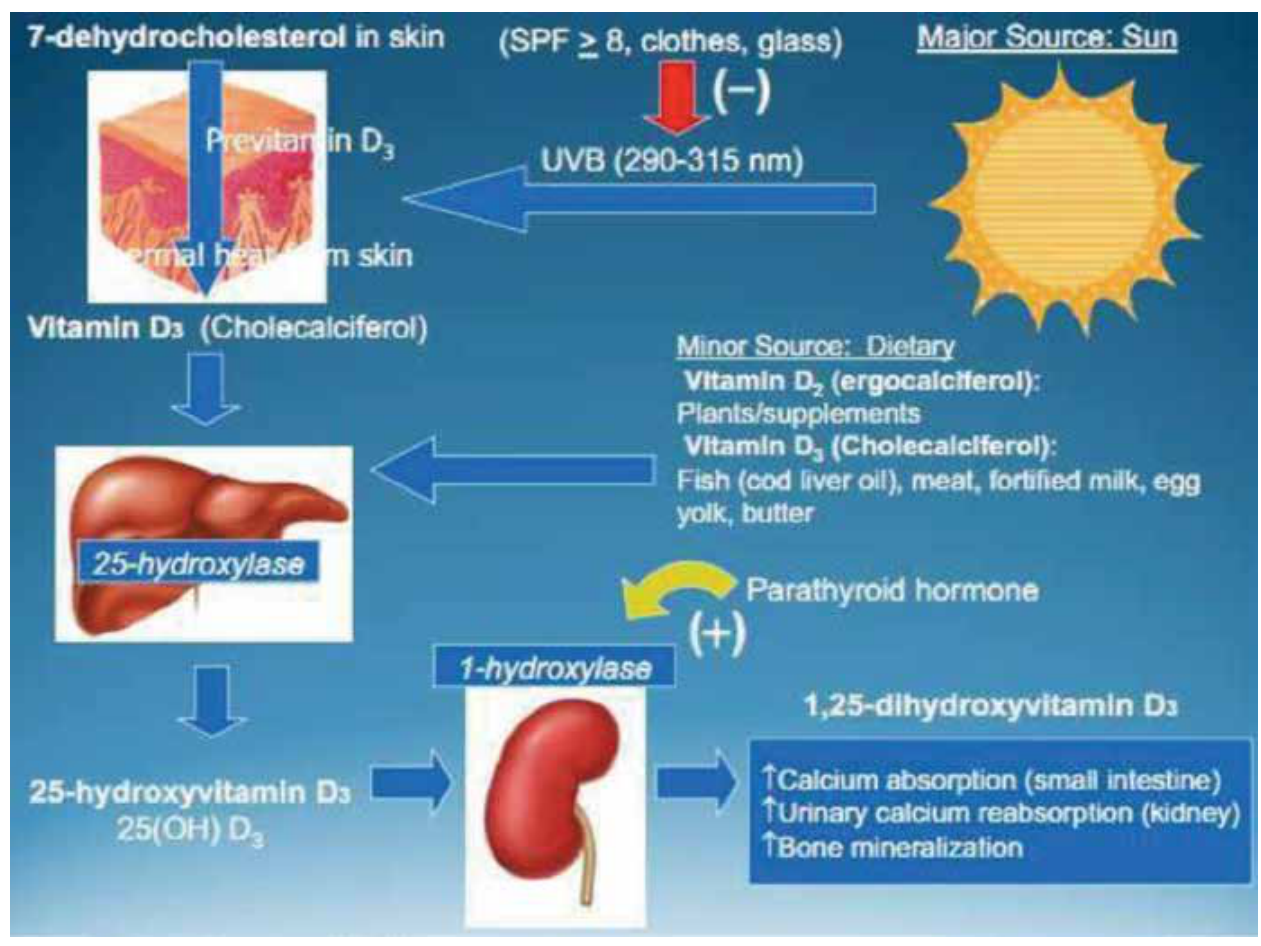
Figure 1: Biological fate of vitamin